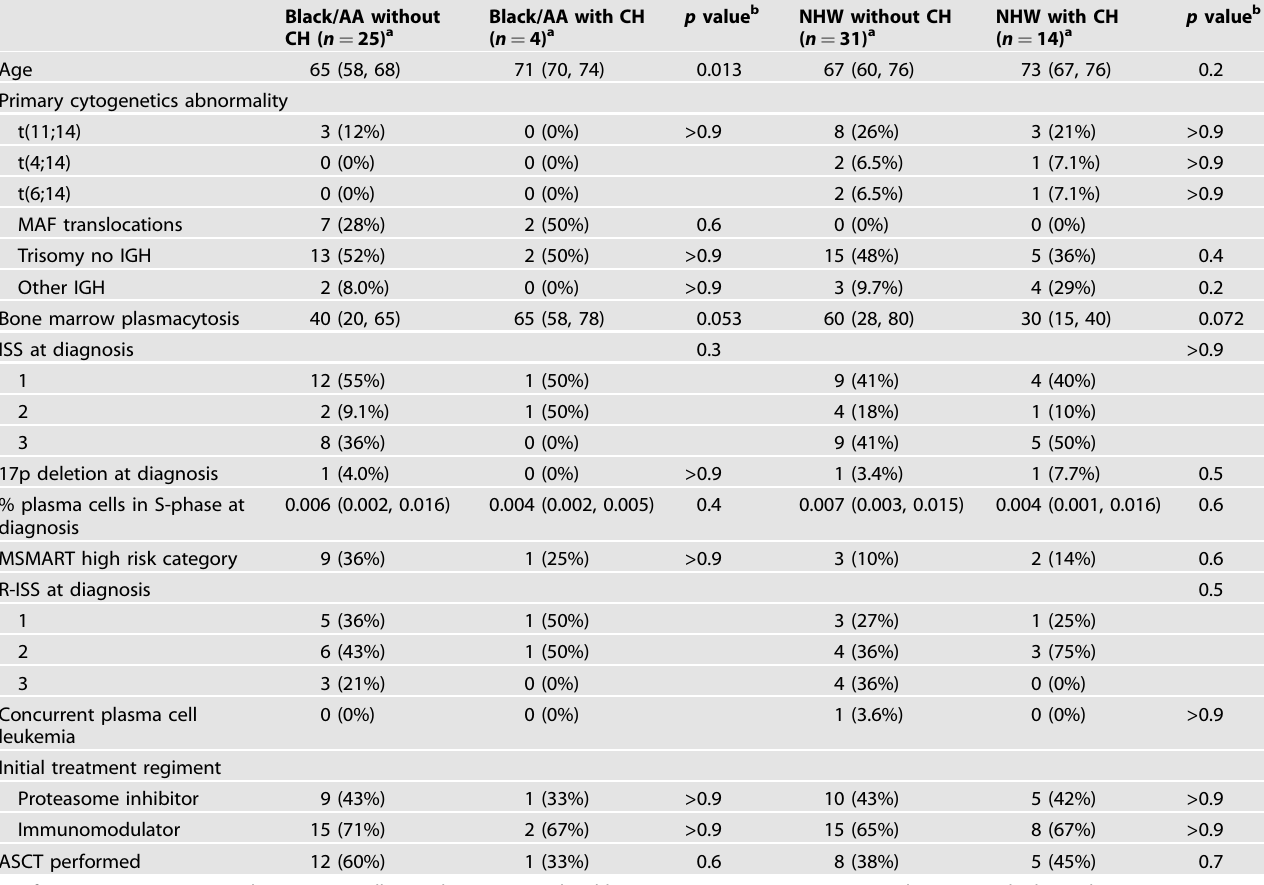
Table 2. Characteristics of Black/AA and NHW patients with MM based on CH